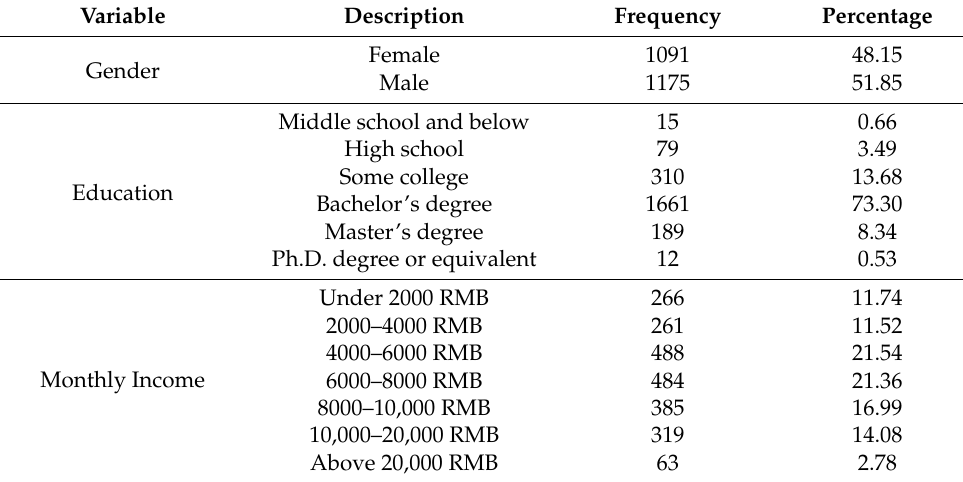
Table A2. Frequency Distribution of Respondents’